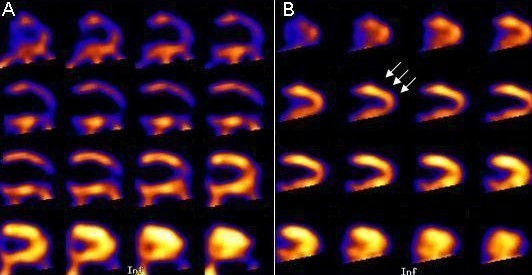
Vertical long axis 99mTc-tetrofosmin SPECT images of patient with myocardial infarction. (A) Perfusion defect at apex and anterior wall before surgical therapy. (B) Three months after cell transplantation and CABG, the apex and anterior wall (arrows) were considered to have normal perfusion.